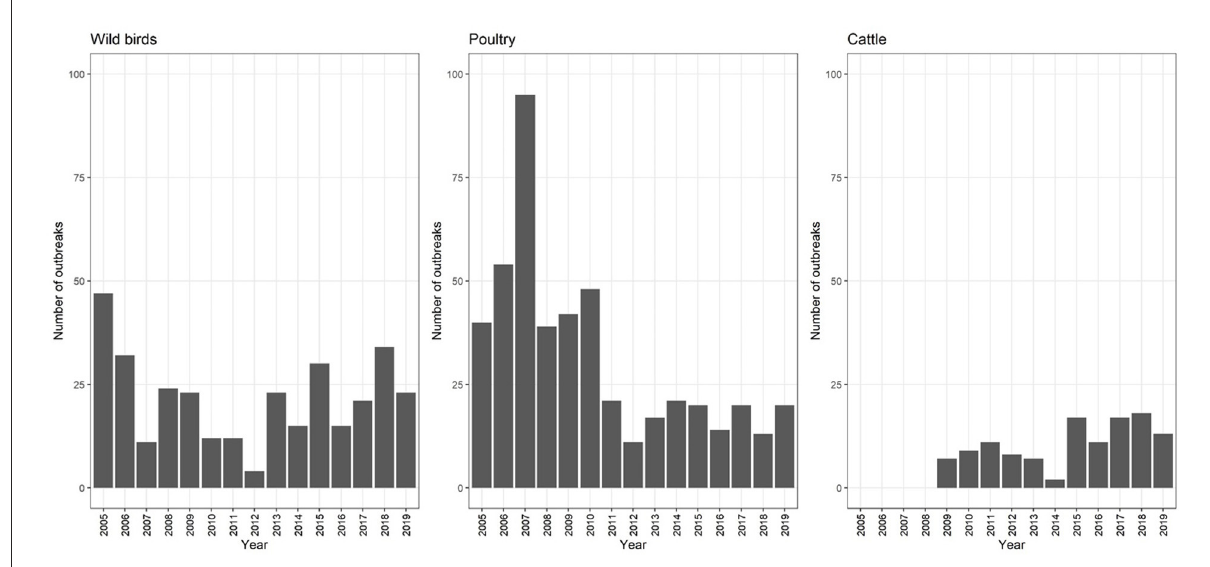
FIGURE3 Evolution of the number of botulism cases in wild birds (2005–2019), outbreaks in poultry (2005–2019) and cattle (2009–2019) ( n = 592).